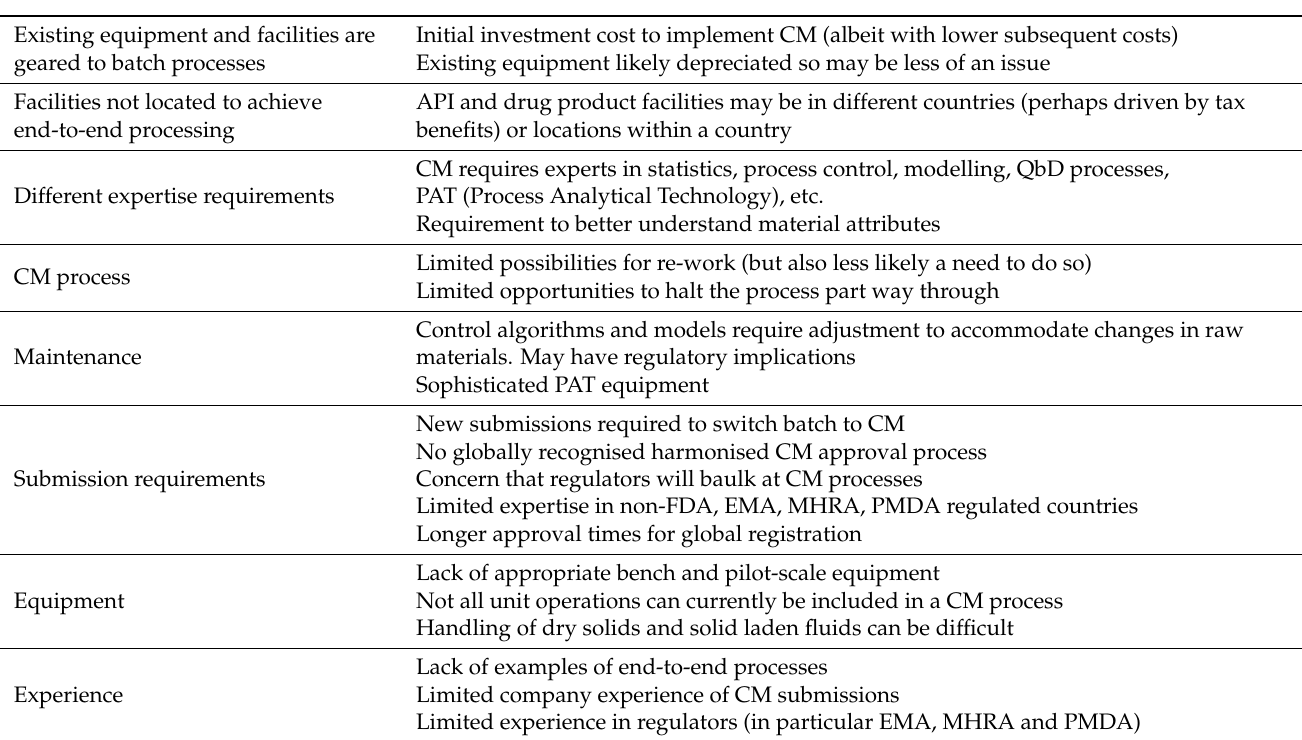
Table 3. Challenges to implementing